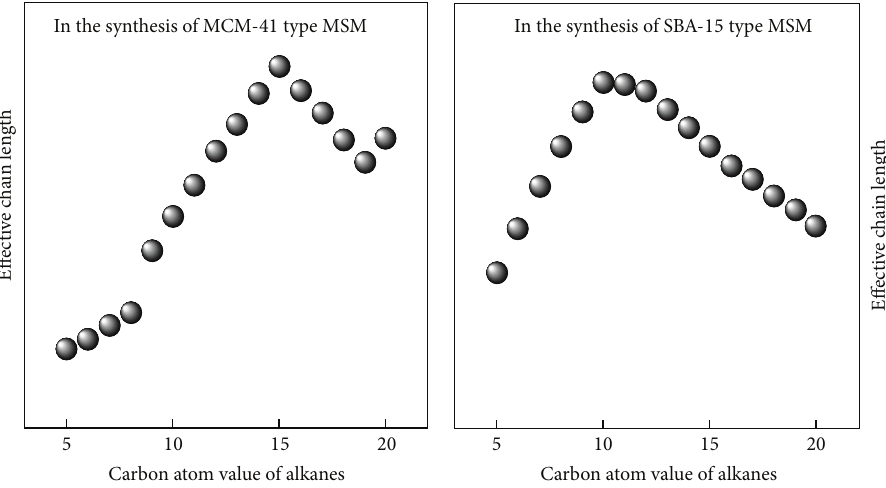
Figure 2: Effective chain length of 𝑛 -alkanes as swelling agent [34, 37, 43, 48, 50, 51, 55,